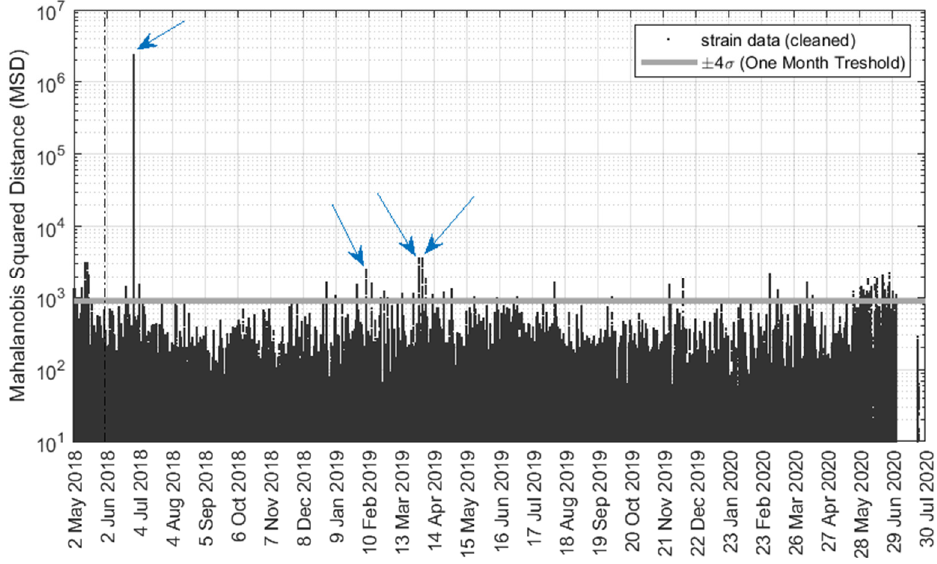
Figure 15. Mahalanobis squared distance applied to the live strains from all thirty gauges. Few outliers are specified with arrows.